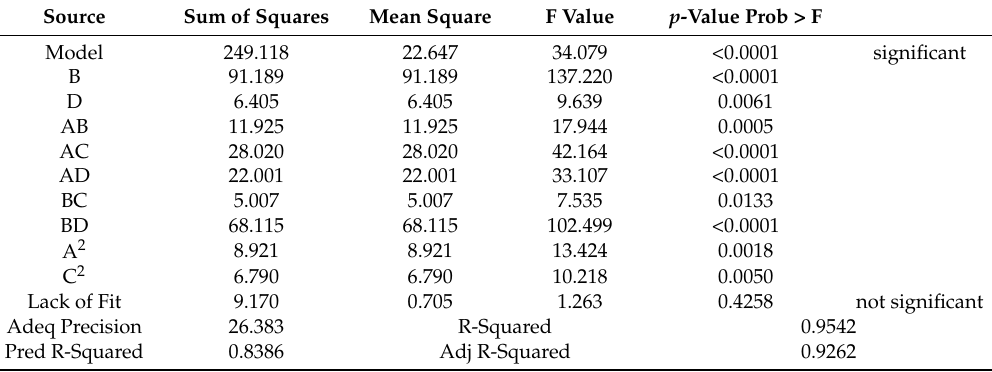
Table A2. Analysis of variance for pore area in response surface quadratic